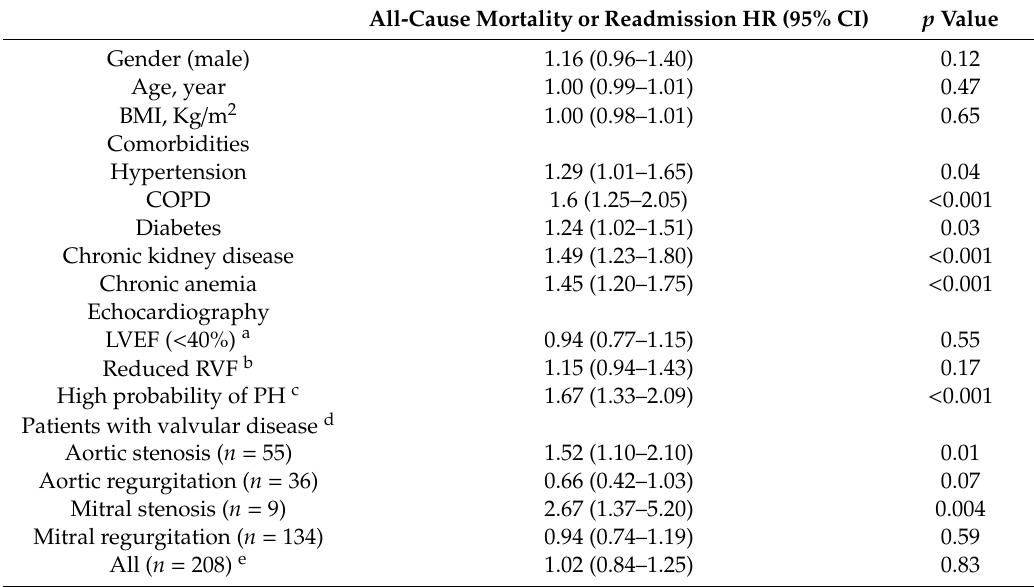
Table 3. Unadjusted analysis of factors associated with all-cause mortality and